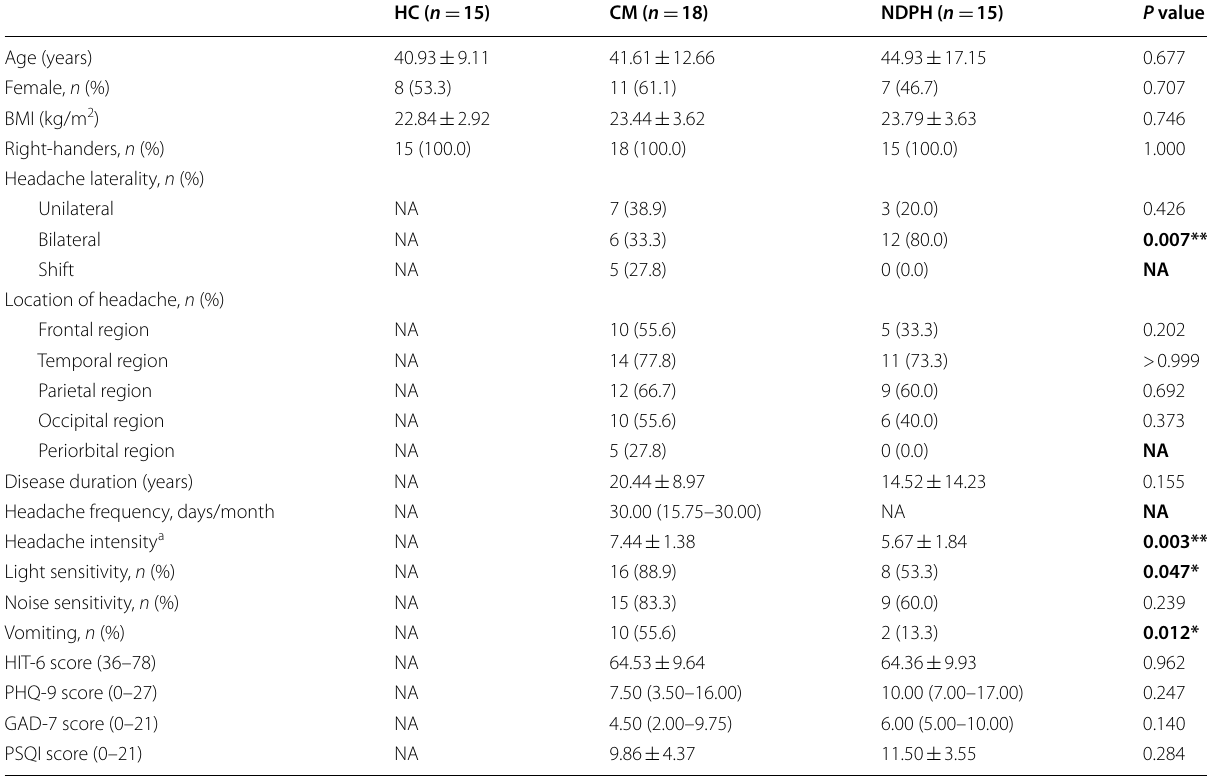
Table 1 Demographic characteristics and clinical data of participants in the three groups